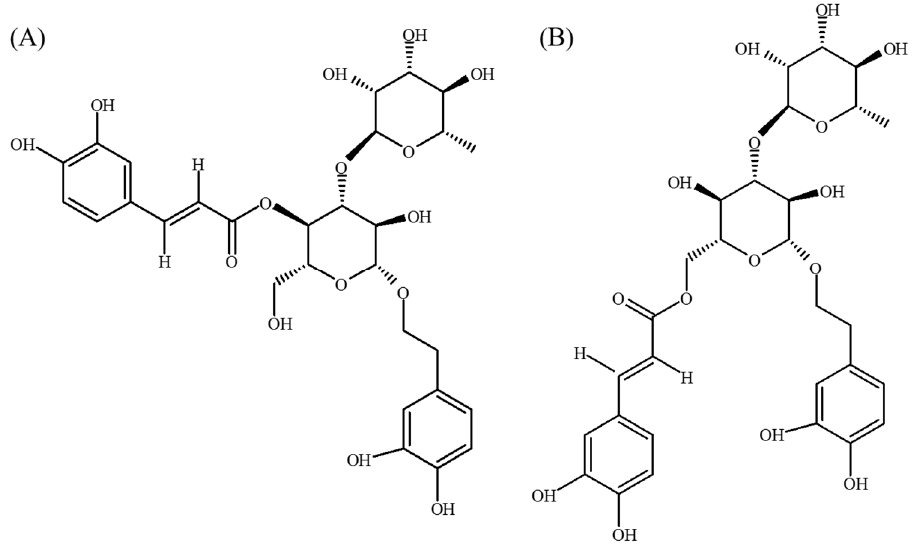
Figure 1. Structures of: ( A ) acteoside; and ( B ) isoacteoside.